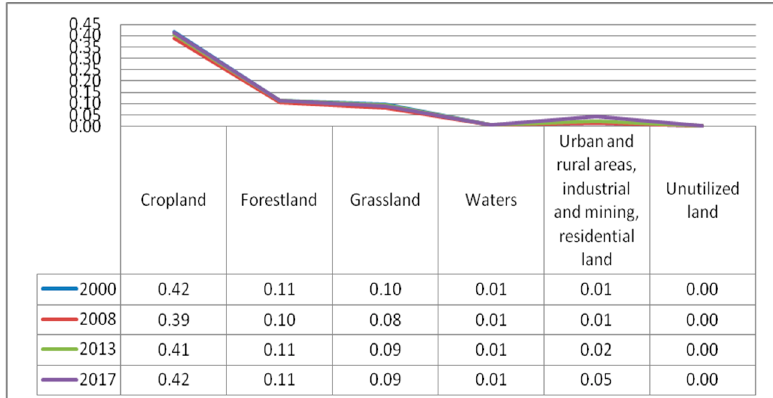
Figure 5. The Patch Density (PD) of various types of landscape.